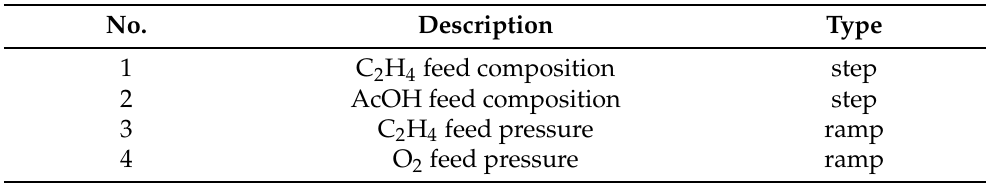
Table 2. Fault description in VAM